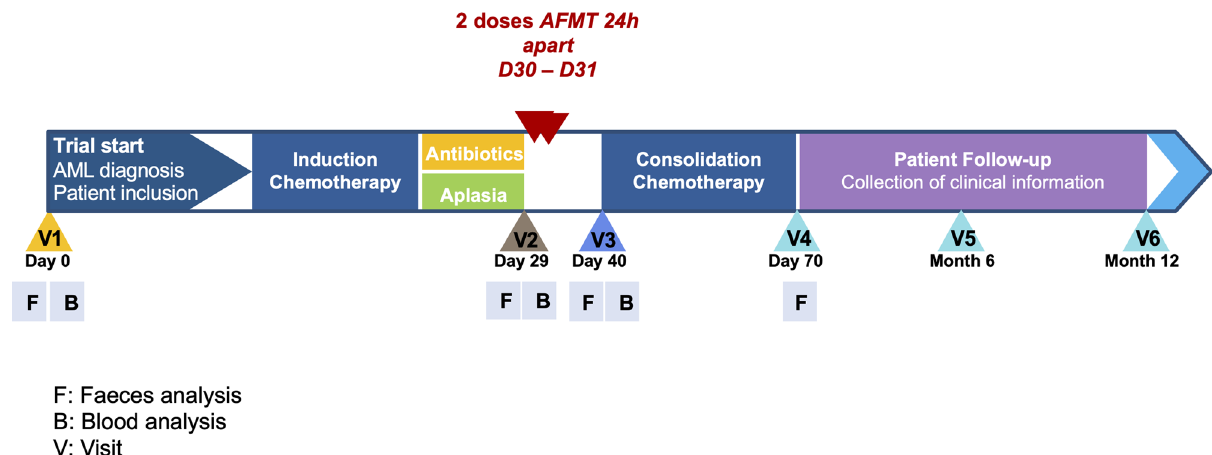
Fig. 1 Study fl ow chart. AML is for acute myeloid leukemia. AFMT, autologuous fecal microbiota transfer; D,